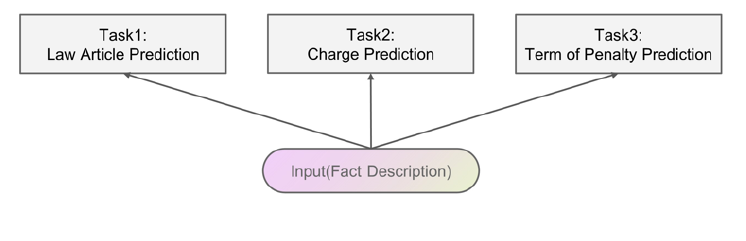
Figure 1. Legal judgment